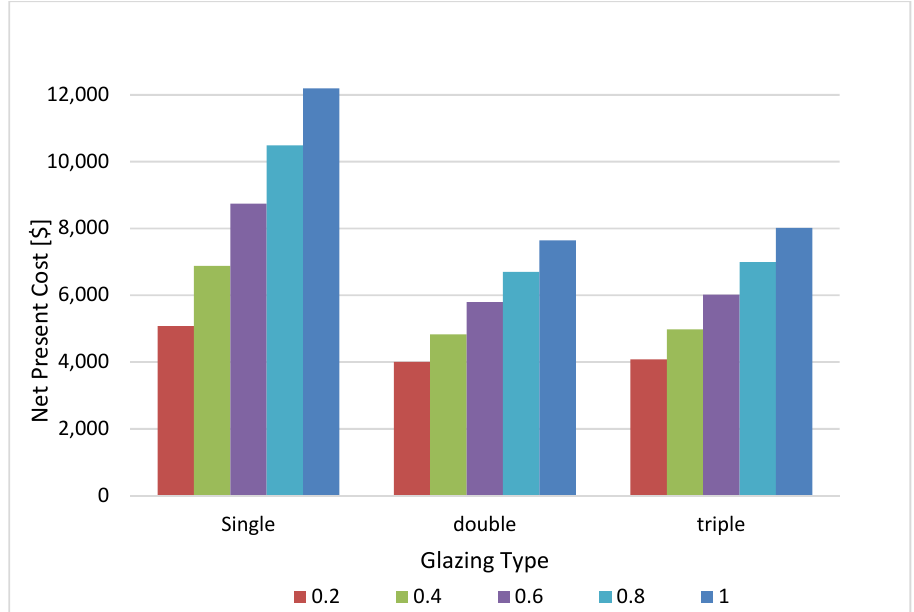
Figure 9. The influence of the window-to-wall ratio and the glazing type on the net present cost of the system in Hakkari (3 cm insulation, NW oriented) .